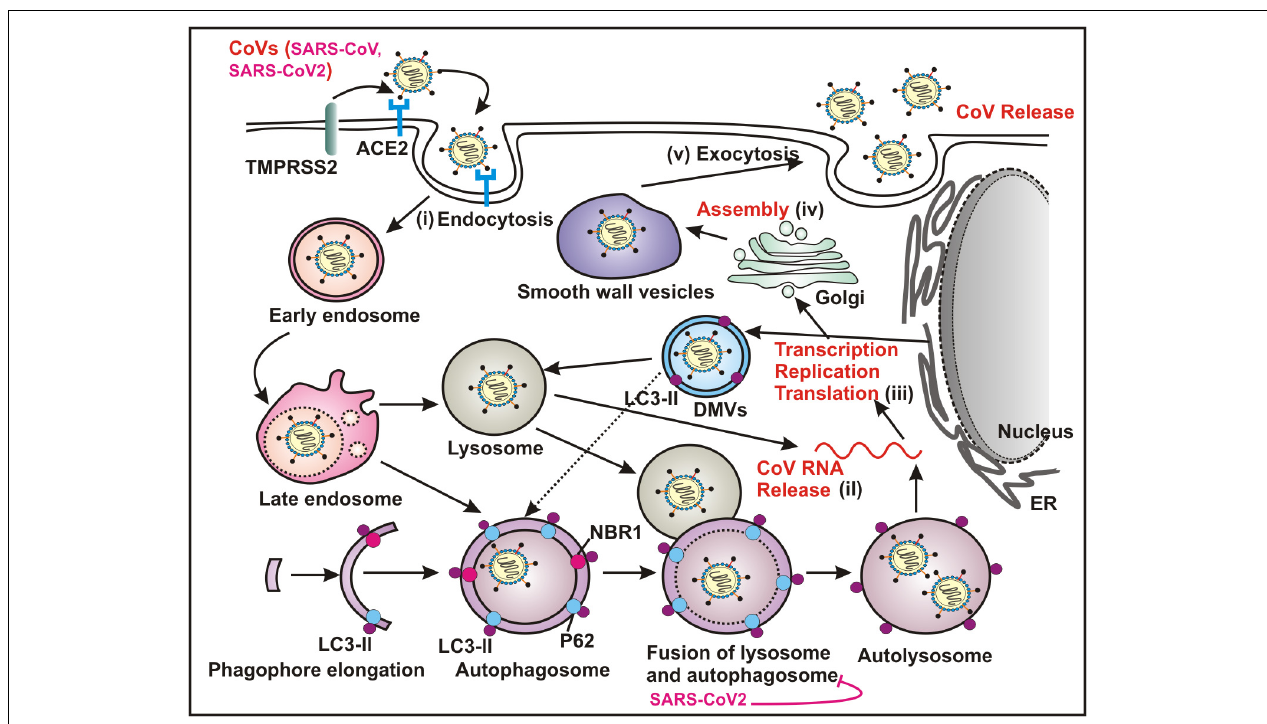
FIGURE 2 | Coronaviruses (CoVs) utilize autophagy pathway for replication. Both SARS-CoV and SARS-COV-2 recognize ACE2 as the cellular surface receptor that mediates the viral entry into the host via endocytosis. Several CoVs utilize ATG5/ATG7 independent autophagy that establishes an endocytic pathway-Golgi route potentially interacting with the multiple stages of virus replication cycle - (i) entry mechanism by endocytosis and fusion of viral and host membranes; (ii) uncoating and releasing the viral genomic RNA; (iii) transcription, replication and translation; (iv) trafficking and assembly and (v) egress by exocytosis. The replication transcription centers are intimately associated with DMVs, which are generated from the ER. DMVs mimic autophagosomes and subsequently these structures fuse with the late endosome, and the lysosome, which results in degradation of the sequestered cytoplasmic cargo. A number of CoVs including SARS-CoV-2 specifically block the fusion between autophagosome and lysosome. ACE2, angiotensin converting enzyme 2; ER, endoplasmic reticulum; DMVs, double membrane